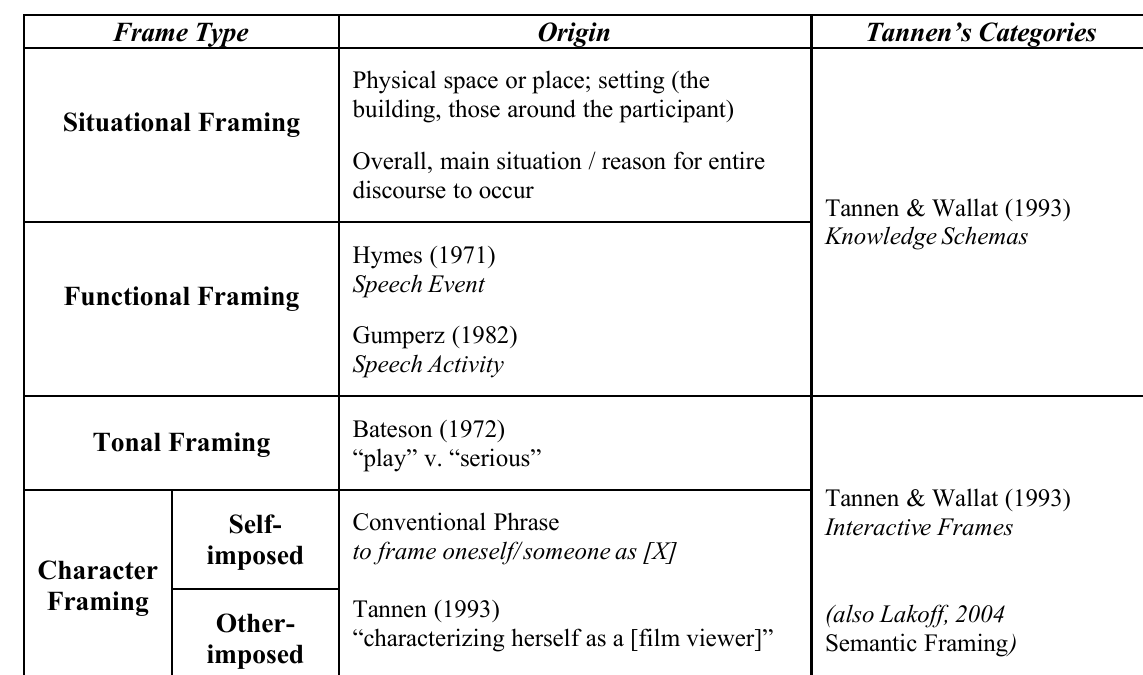
Qualitatively Different Types of